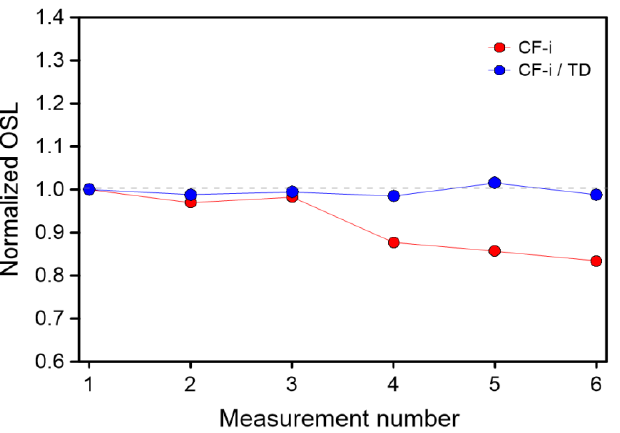
Figure 6. Comparison of sensitivity changes for CF-i sample without and with the test dose correc- tion procedure.